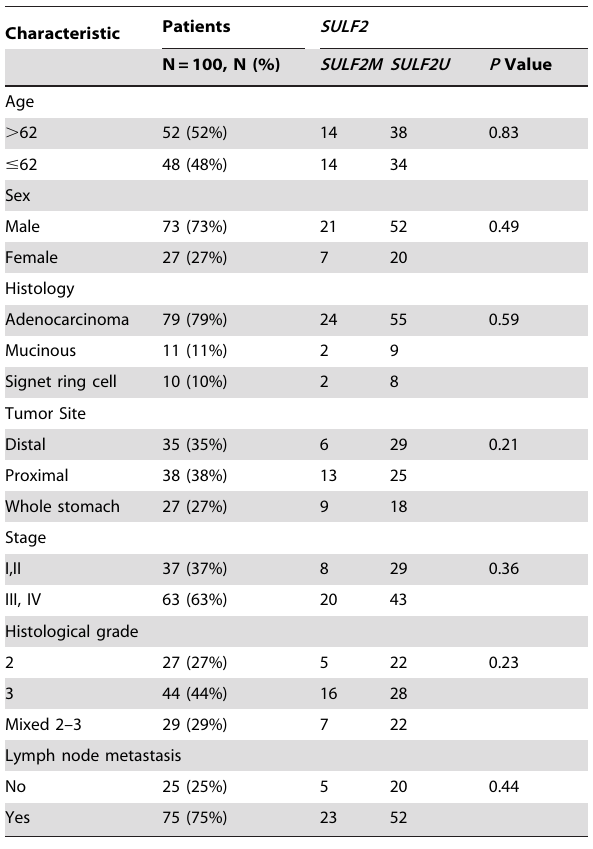
Table 1. Patient characteristics.